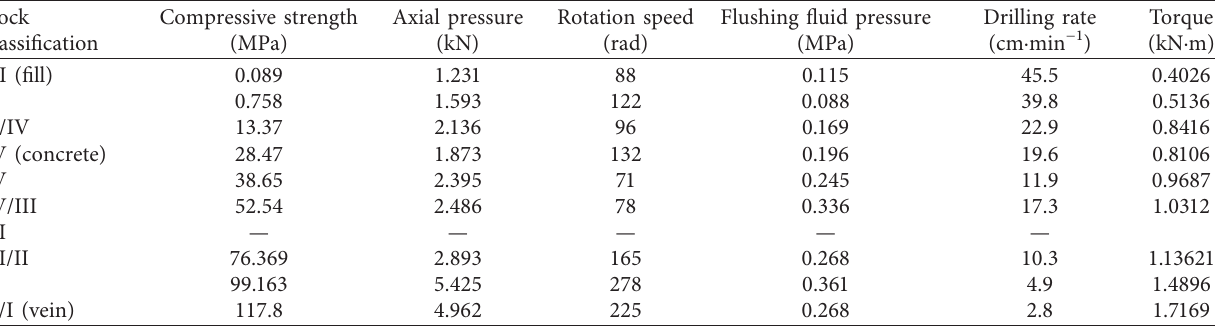
Table 9: Drilling parameters of hole 2.